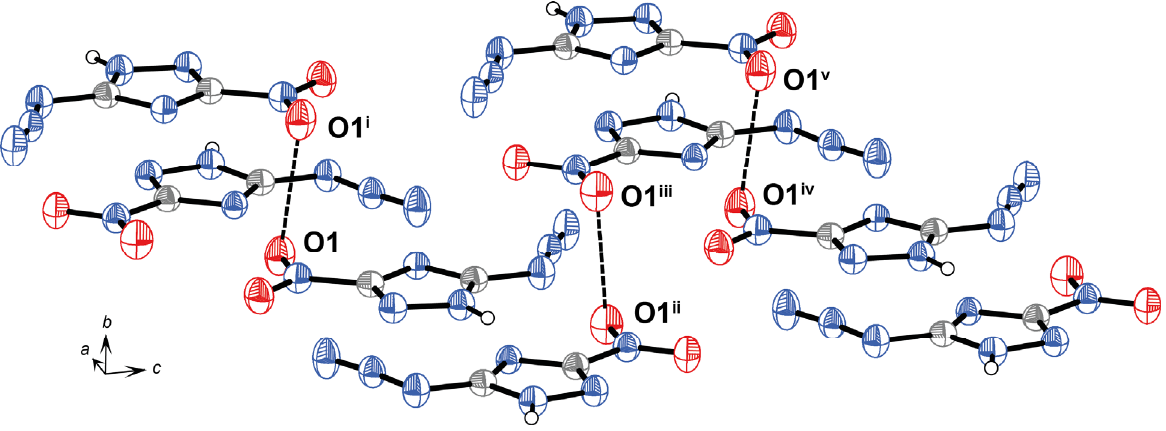
Figure 3. Packing scheme of 1 , showing the short contacts connecting the layers along the b -axis. Symmetry codes: (i) − x + 1, y + 0.5, − z ; (ii) x − 0.5, − y + 0.5, − z + 0.5; (iii) − x + 0.5, − y + 1, z + 0.5; (iv) x , y , z + 1; (v) − x + 1, y + 0.5, − z + 1.